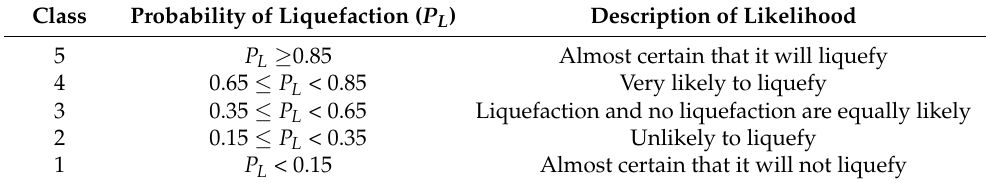
Table 4. Liquefaction likelihood classification